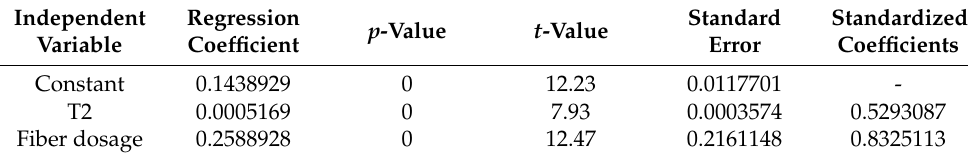
Table 6. Values of regression coefficients of G F .